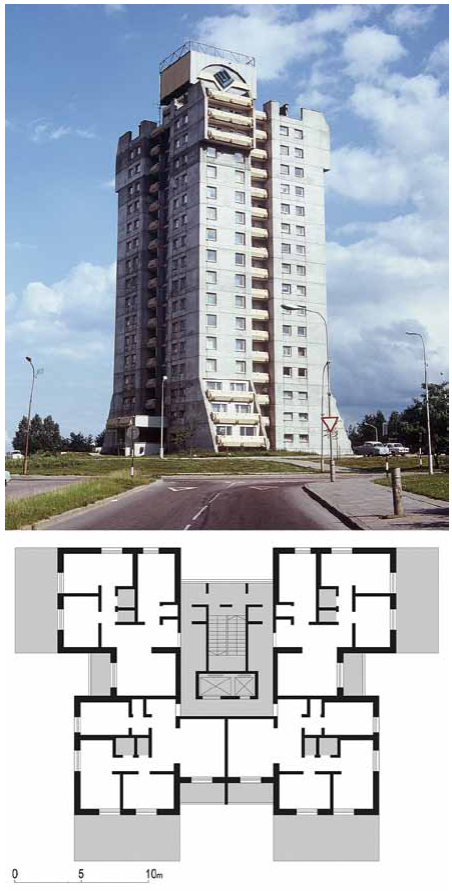
Fig. 9. 16-storey tower block in lazdynai (archit. Česlovas Mazūras, constr. st. in